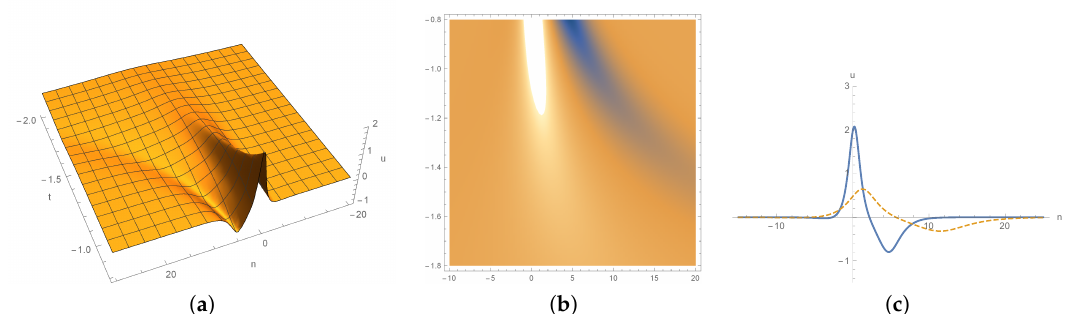
Figure 6. u n given by (38) with (cid:101) = − 1 for c 1 = 1, c 2 = 0.6, α 1 = 1 and α 2 = − 1. ( a ) shape and motion; ( b ) a contour plot of ( a ) with range n ∈ [ − 10,20 ] and t ∈ [ − 1.8, − 0.8 ] ; ( c ) waves in blue (solid line) and yellow (dotted line) stand for plot ( a ) at t = − 1 and t = − 0.8, respectively.